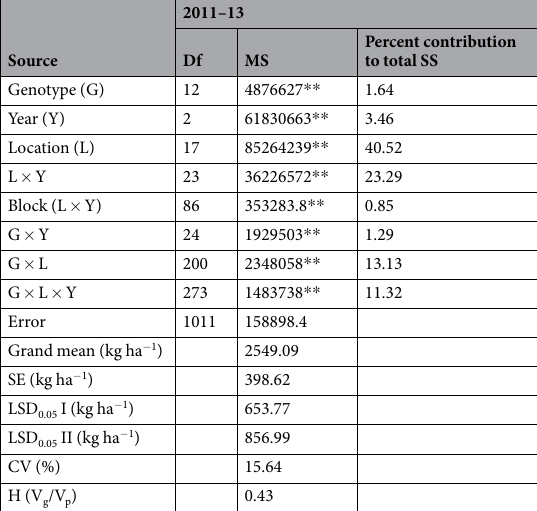
Table 2. ANOVA and basic statistics across three years (2011–13). Df = degrees of freedom; MS = mean square; SS = sum of squares; ** − = Significant at 1% level of